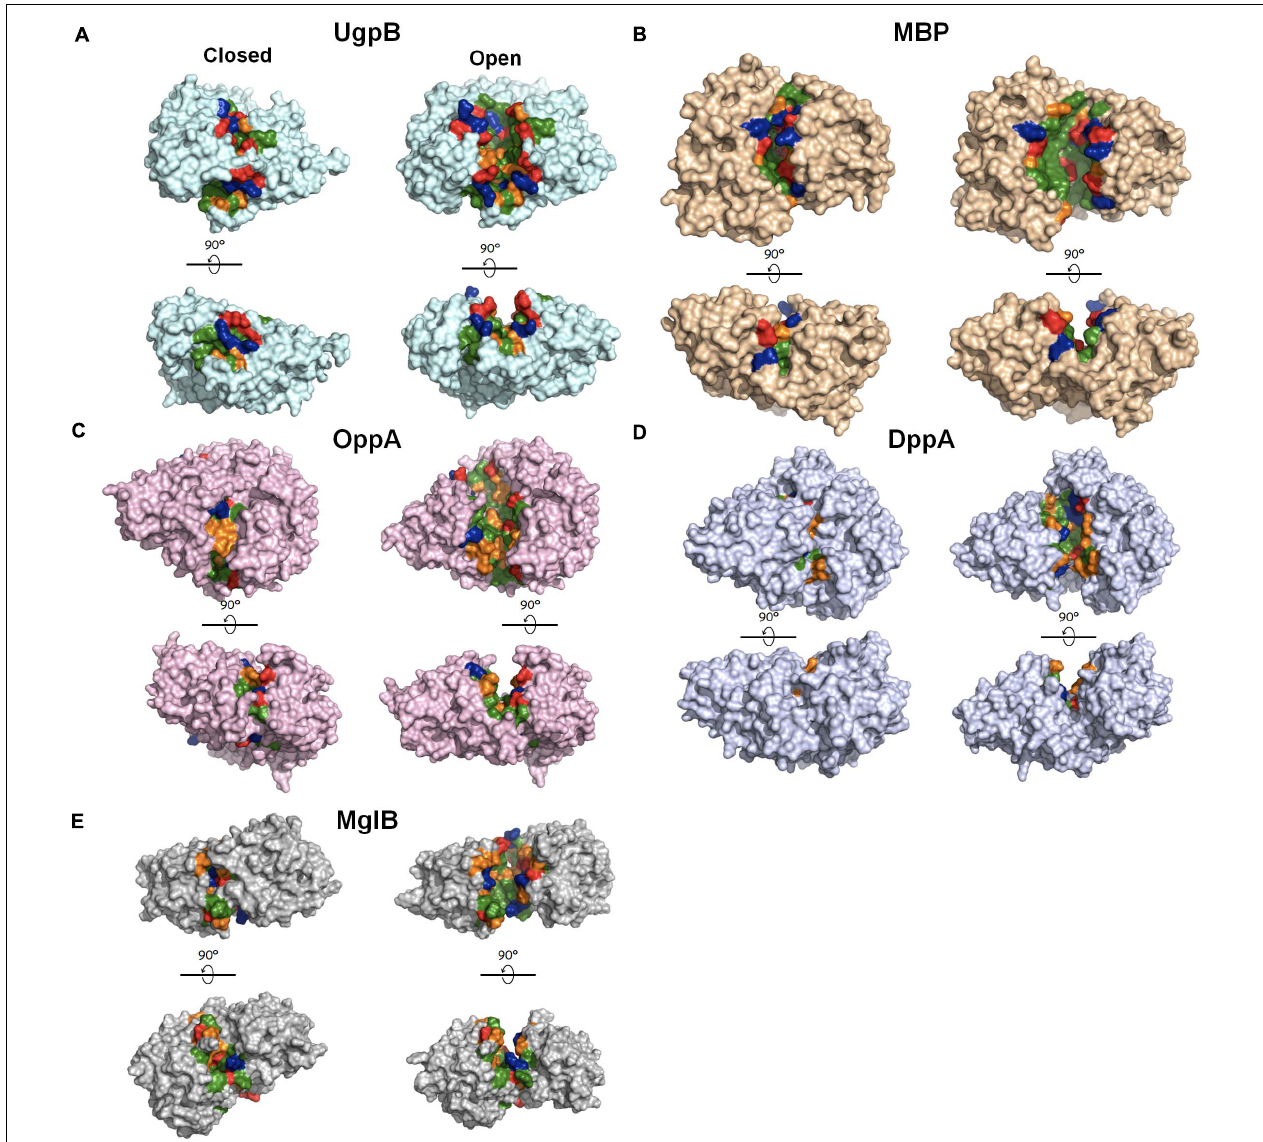
FIGURE 4 | Crystal structures of periplasmic substrate-binding proteins with open and closed conformations. The ligand-free open conformations and ligand-bound closed conformations are shown on the right and left, respectively, for each panel. Upon the release of the ligand, the buried core region is exposed to the solvent. The solvent–exposed cavities in the open conformation were detected using the CASTp 3.0 server (Tian et al., 2018) and were highlighted according to the characteristics of the residues (green, hydrophobic residues; orange, polar residues; blue: positively charged residues; red: negatively charge residues. (A) E. coli UgpB (pdb: 6 × 84 [open] and 4aq4 [closed]); (B) E. coli MBP (MalE, pdb: 1omp [open] and 1anf [closed]); (C) E. coli OppA (pdb: 3tch [open] and 3tcg [closed]); (D) Pseudoalteromonas sp. DppA (pdb: 4qfk [open] and 4qfn [closed]); (E) Treponema pallidum MglB (pdb: 6bgd [open] and 6bgc [closed]). Figures were made in